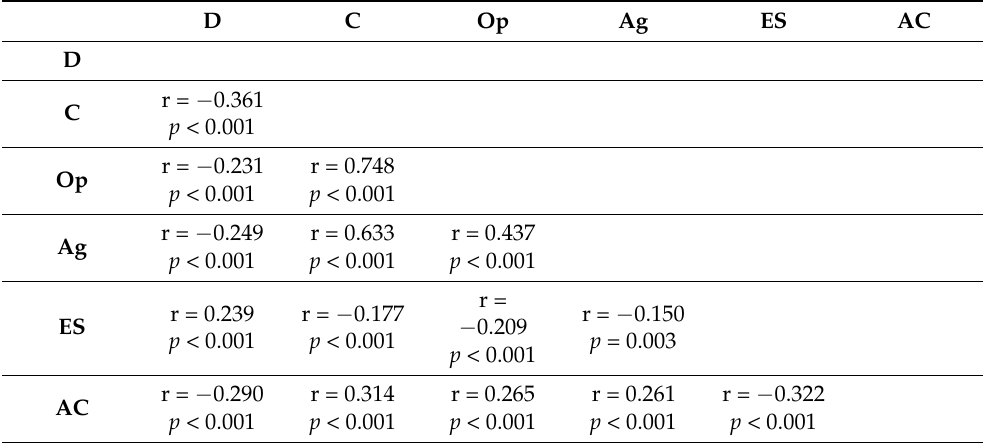
Table 4. Parametric variable correlations ( N = 223).